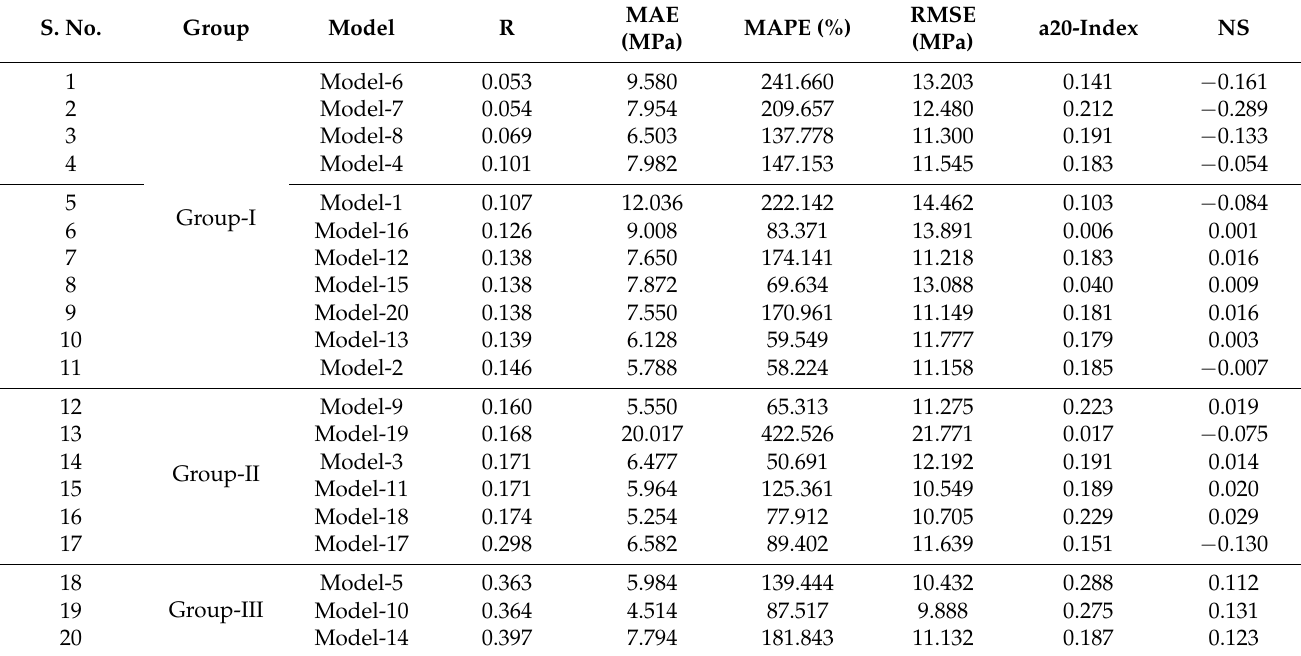
Table 5. Division of models in three groups.